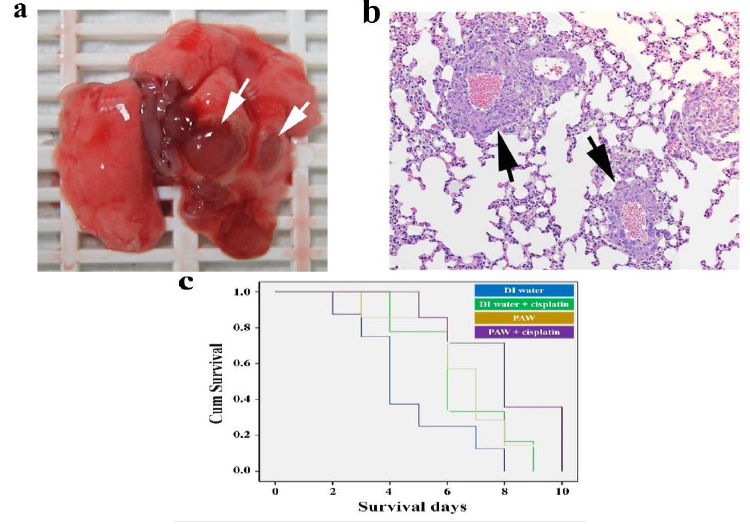
Figure 6. Pathological features and survival curve on the LLC-1-xenograft mice. ( a ) Lung metastasis in LLC-1-xenograft mice: gross observation of the whole lung (arrows); ( b ) Lung metastasis in LLC-1-implanted mice, HE staining (right, 200× magnification) of metastatic tumor lesions (arrows); ( c ) The overall survival time (days) of LLC-1-implanted mice treated with DI water ( n = 9), DI water plus cisplatin ( n = 8), PAW ( n = 7), or PAW plus cisplatin ( n = 7)